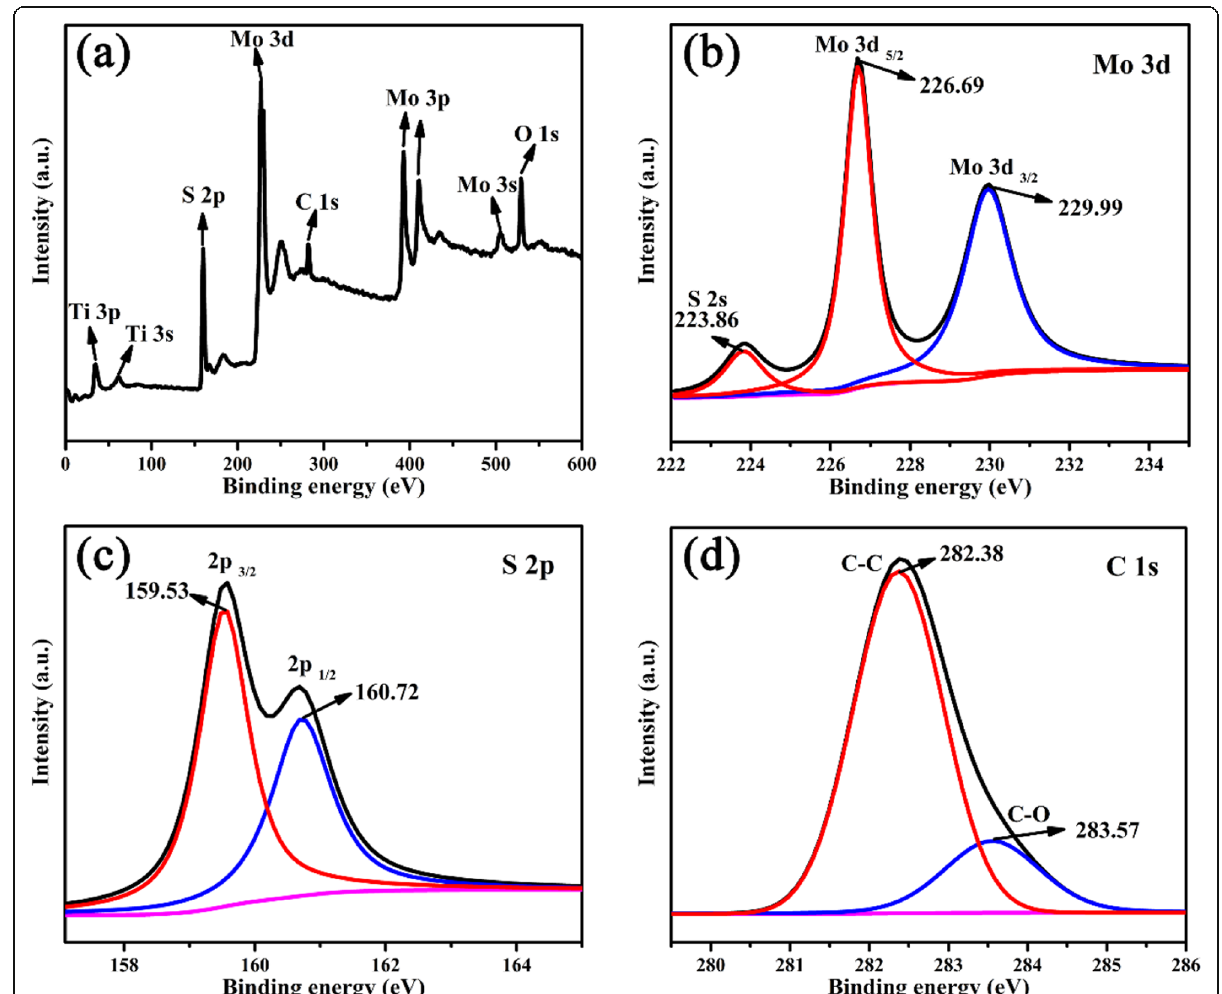
Fig. 5 a XPS survey spectra and high resolution XPS spectra of b Mo 3d, c S 2p, d C 1 s in TM